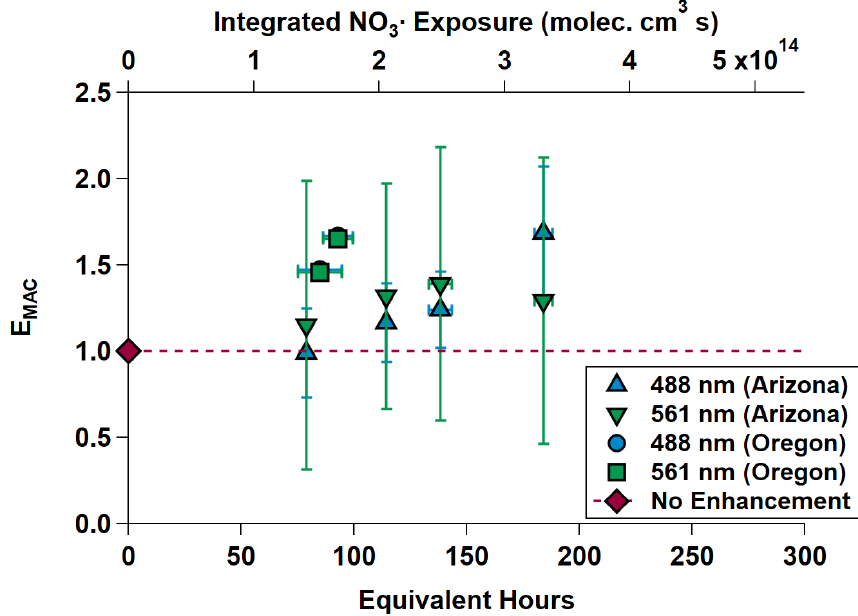
Figure 5. MAC( λ ) enhancements at 488 and 561nm during NO 3 , Arizona (triangles) and NO 3 , Oregon (square and circle; the circle is partially obscured by the square). The dashed gray line is the “no enhancement” line. The Arizona experiment data show an increasing trend in MAC( λ ) with increasing equivalent age. The Oregon data on their own do as well, but in the context of the Arizona data, the chemical species present in the smoke plume in Oregon appear to have been much more reactive towards NO 3 (cid:113) calculated from the NO 3 exposure in the OFR and assuming an average ambient NO 3 al., 1991).